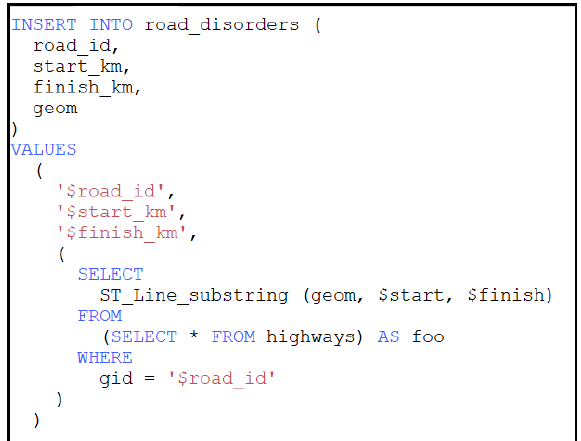
Figure 16. Adding segmented geometry data to database management system